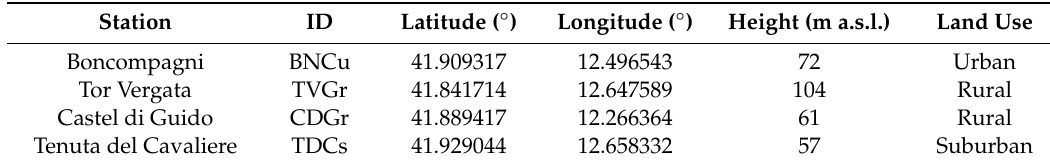
Table 1. ARPA Lazio micro-meteorological stations.